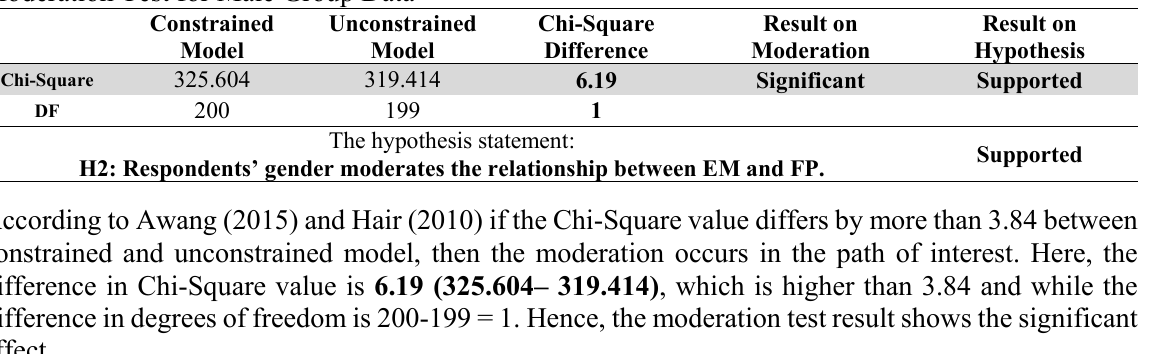
Unconstrained Model